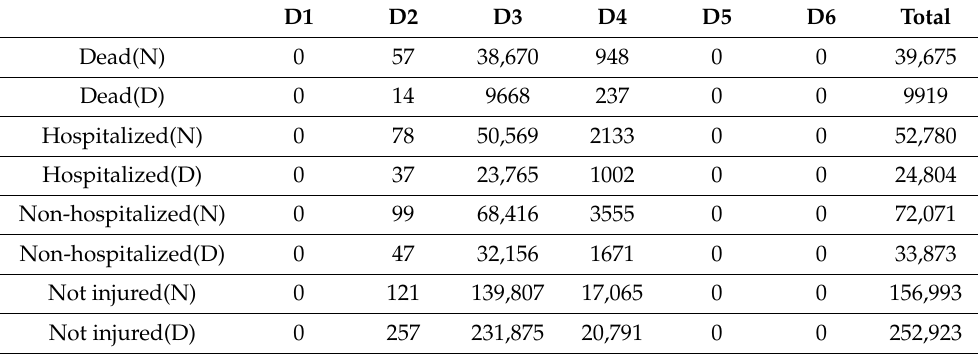
Table 28. Number of casualties in the 1780 earthquake in District 10 of